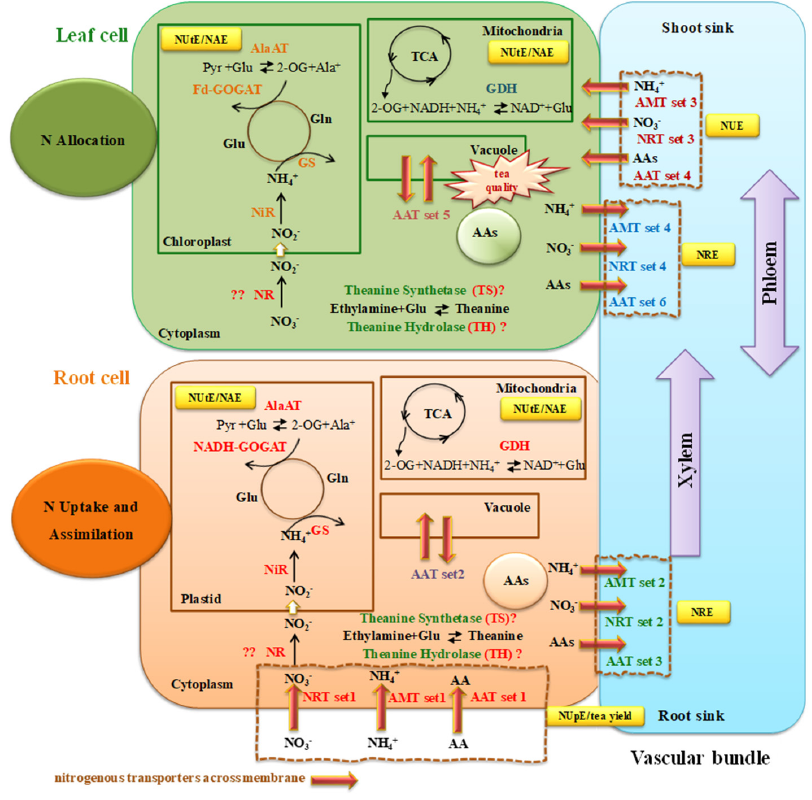
Figure 7. Integrative schematic model of genes proposed to mediate the physiological functions of N uptake, assimilation, and transport (translocation and remobilization) in roots and shoots based on this transcriptome case. Genes in red bold expressed either higher or lower in response to external N treatments.